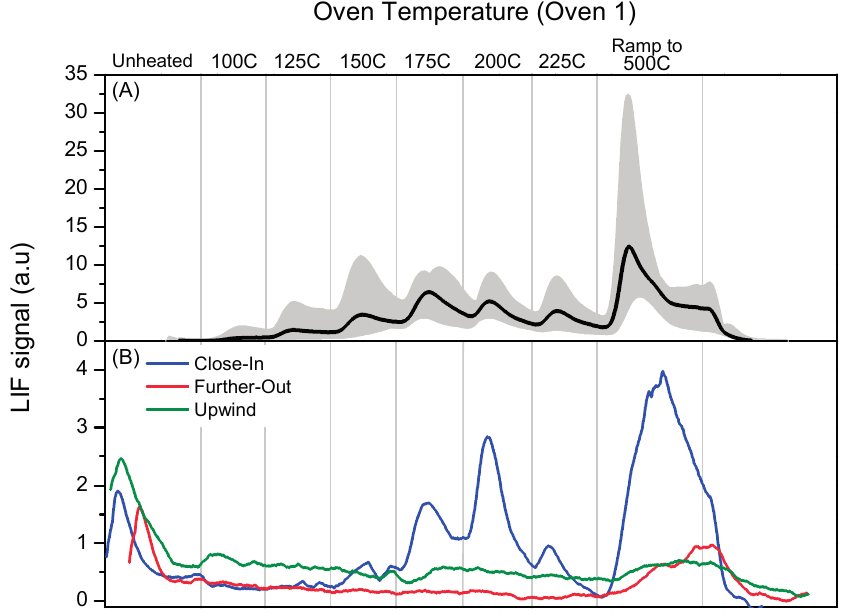
Figure 5. Panel ( A ): Calibration profile obtained from average of six PTD profiles using Oven 1 program for denuder loaded with pure HgCl minimum and maximum signals observed; Panel ( B ): Dissociation profiles obtained using Oven 1 program for airship samples collected 28 February